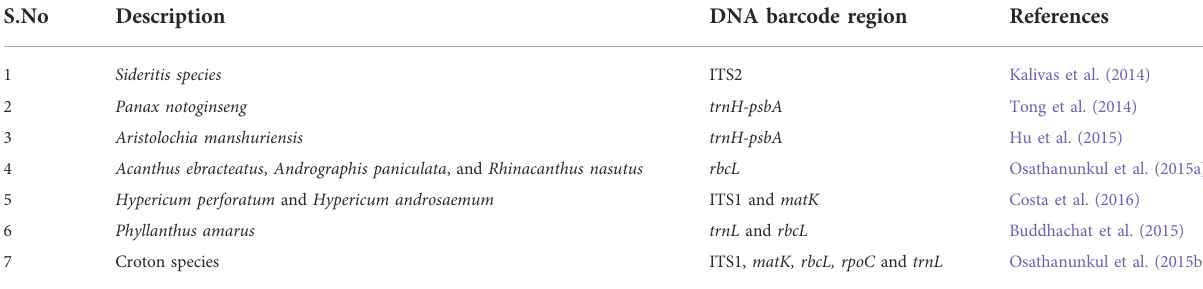
TABLE 3 List of recommended barcode locus/loci for the application of Bar-HRM in medicinal plant identi fi